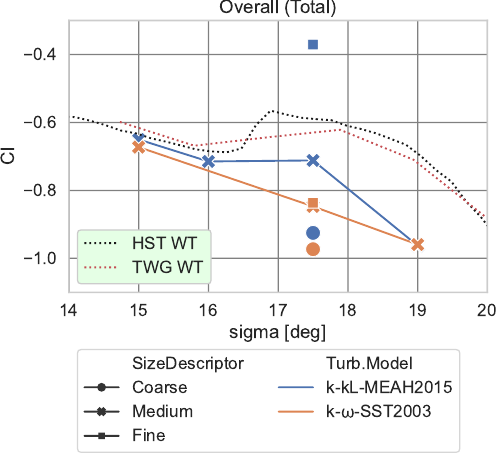
Figure 6. Rolling moment coefficient predictions in comparison with experimental data; M = 0.85, = 5 × 10 5 , λ = Re d Ref